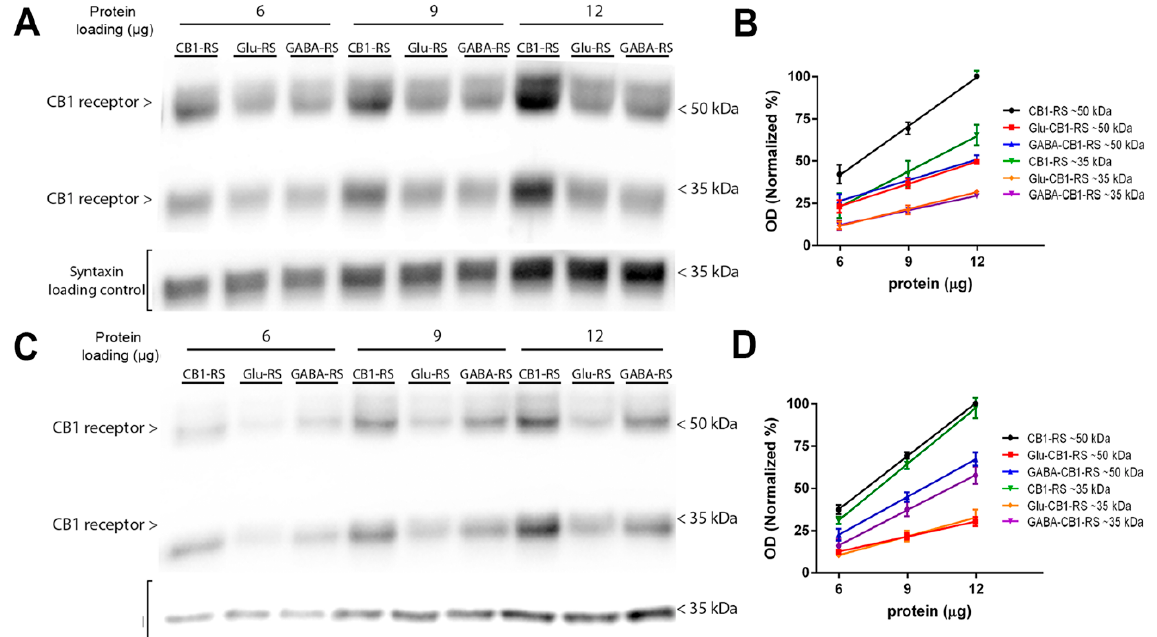
Figure 4. CB1 receptor protein levels in synaptosomes obtained from frontal cortical and hippocampal tissue of Glu-CB1-RS, GABA-CB1-RS, and CB1-RS mice. Representative Western blots carried out by immunoblotting increasing amounts of frontal cortical ( A ) and hippocampal ( C ) synaptosomes (6, 9 or 12 µ g/line). CB1-Immunogenes antibody was used for detecting CB1 receptor protein, and anti-syntaxin antibody was used as a loading control. The molecular weights depicted correspond to the signal of the standard markers. ( B ). Regression analysis of curves generated by optical density (OD) values of the immunoreactive signals of CB1 receptor from frontal cortical synaptosome membranes. ~50 kDa: CB1-RS: y = 9.64x − 16.34, r 2 = 0.99. Glu-CB1-RS: y = 4.39x − 3.08, r 2 = 0.99. GABA-CB1-RS: y = 4.41x − 1.81, r 2 = 0.99. ~35 kDa: CB1-RS: y = 6.79x − 22.23, r 2 = 0.98. Glu-CB1-RS: y = 3.33x − 8.41, r 2 = 0.99. GABA-CB1-RS: y = 2.88x − 5.20, r 2 = 0.99. ( D ). Regression analysis of curves generated by optical density (OD) values of the immunoreactive signals of CB1 receptor from hippocampal synaptosome membranes. ~50 kDa: CB1-RS: y = 10.52x − 26.04; r 2 = 0.99; Glu-CB1-RS: y = 2.97x − 5.87; r 2 = 0.99. GABA-CB1-RS: y = 7.48x − 22.97, r 2 = 0.99. ~35 kDa: CB1-RS: y = 11.13x − 36.19; r 2 = 0.99. Glu-CB1-RS: y = 3.72x − 12.54; r 2 = 0.99. GABA-CB1-RS: y = 6.97x − 26.17; r 2 = 0.99. Analysis of the CB1 receptor protein expression by the slope comparison method in frontal cortical an in hippocampal synaptosomes is shown in the Supplementary Table